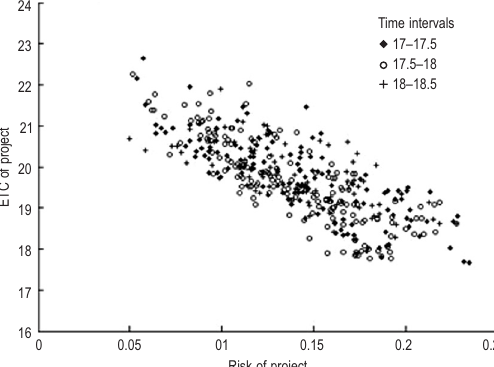
Fig. 8. Categorization of results based on their duration